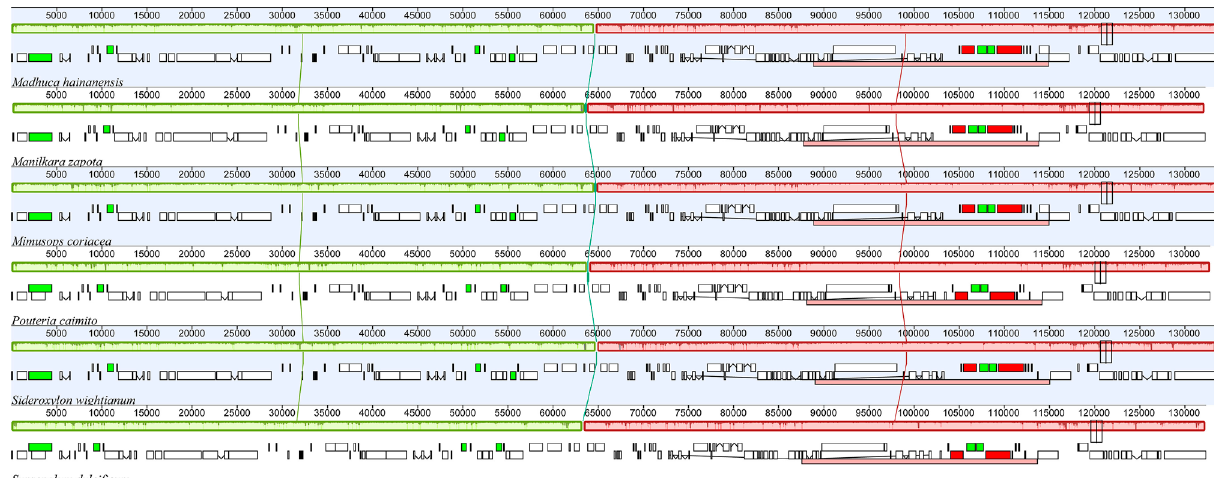
Figure 1 ‒ Progressive Mauve alignment showing synteny and rearrangements for six Sapotaceae plastomes. Species names are indicated below each respective